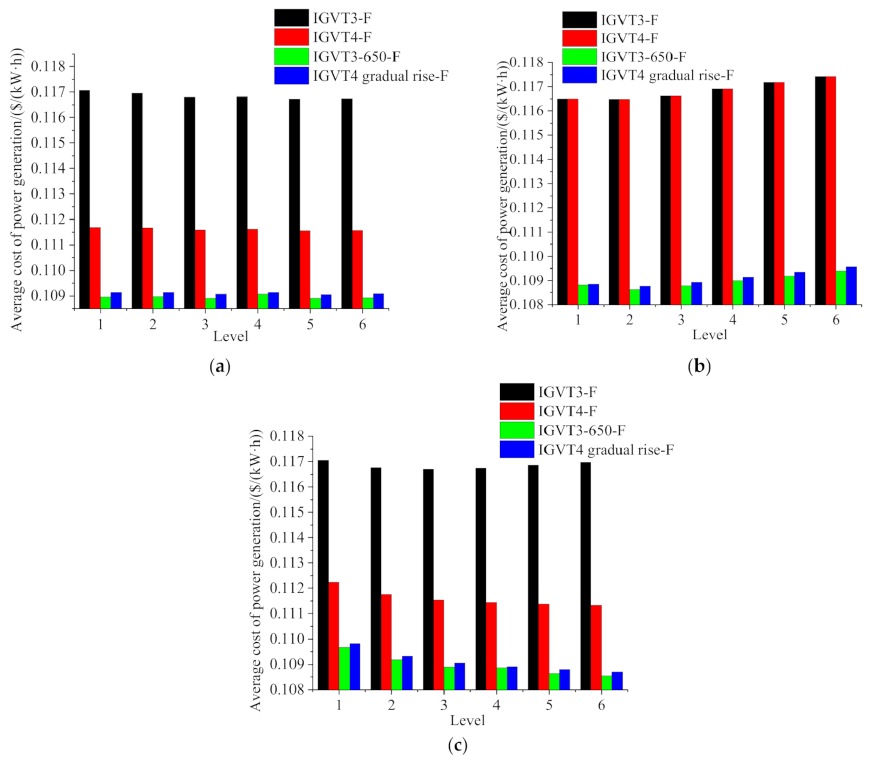
Figure 7. The average power generation cost under all levels (GT 50% load rate). ( a ) LP ( b ) IP ( c ) HP.